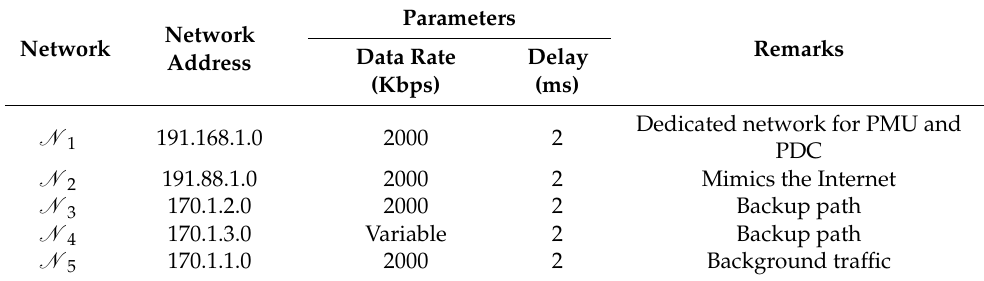
Table 1. Key ns-3 configuration parameters for the SCN.